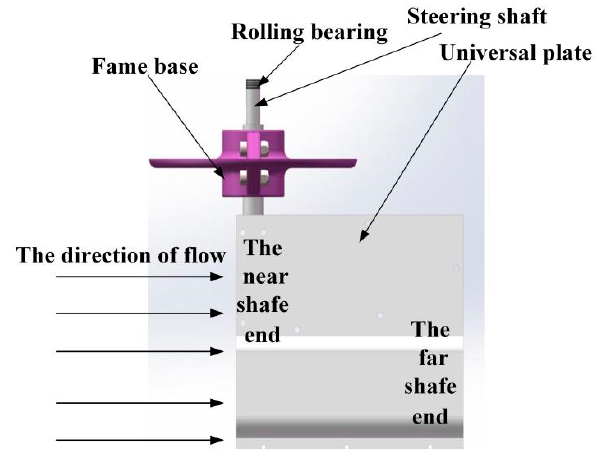
Figure 2. Universal plate adaptive flow.